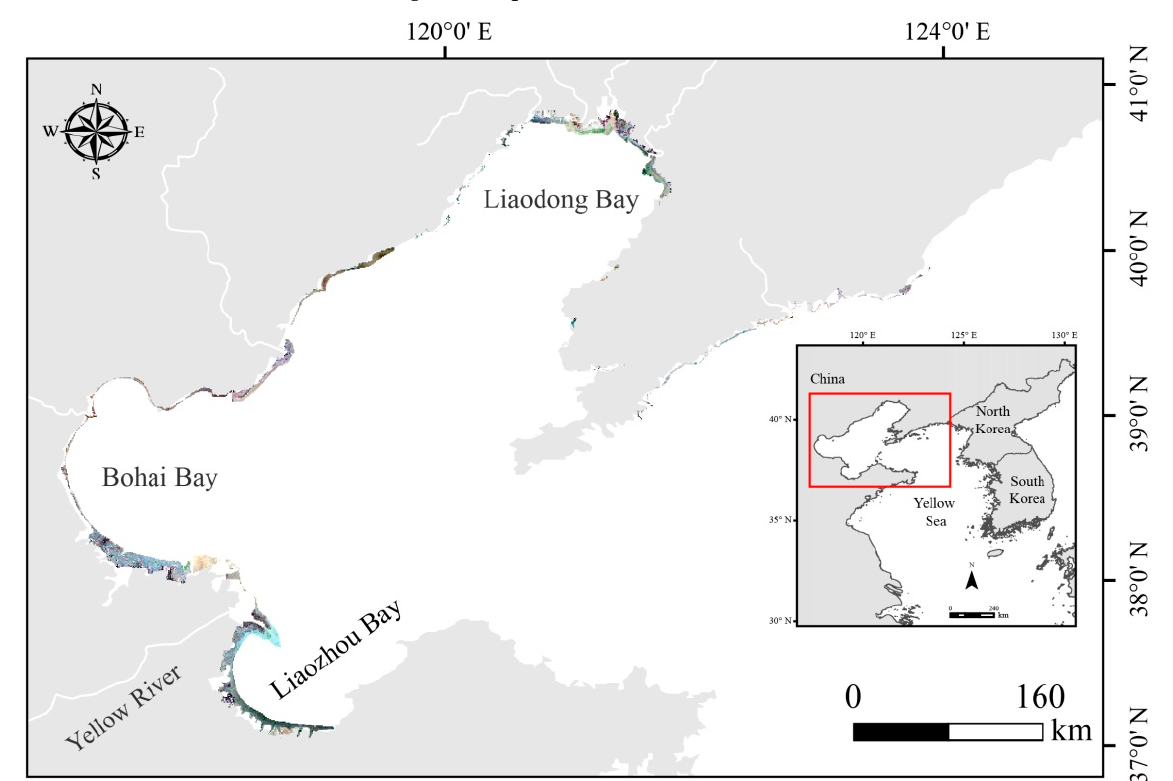
Figure 1. Location of the Northern Yellow Sea of China with subset RS images of 1988.